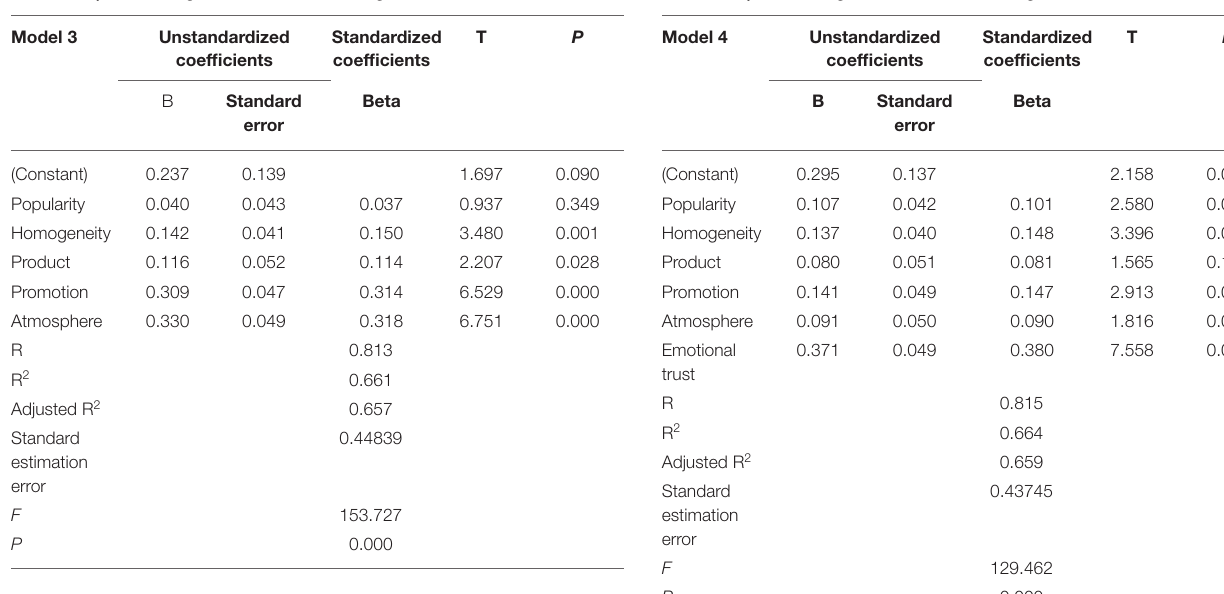
TABLE 11 | Model 3 regression coefficients and goodness-of-fit tests. TABLE 12 | Model 4 regression coefficients and goodness-of-fit